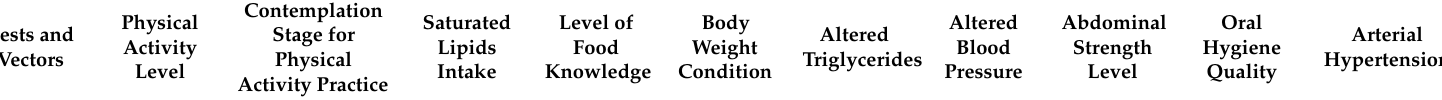
Table 5. Most significant Spearman’s correlation coe ffi cients among variables under